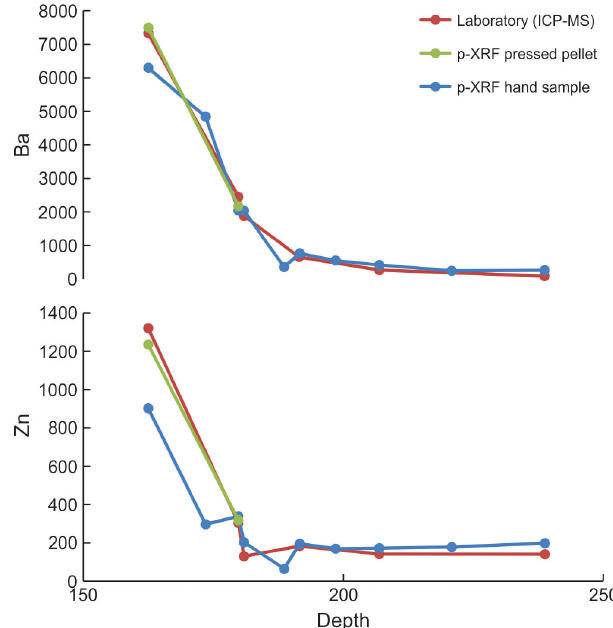
Figure 15. Ba and Zn geochemical profiles along the hanging wall in core AGI-888. Depth is in metres along the core; Ba and Zn con- centrations are in micrograms per gram (µgg − 1